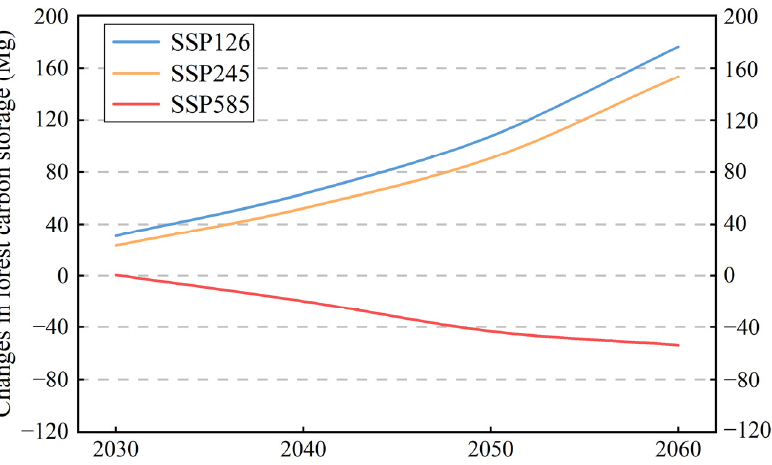
Figure 10. Changes in forest ecosystem carbon storage under different scenarios compared to 2020.